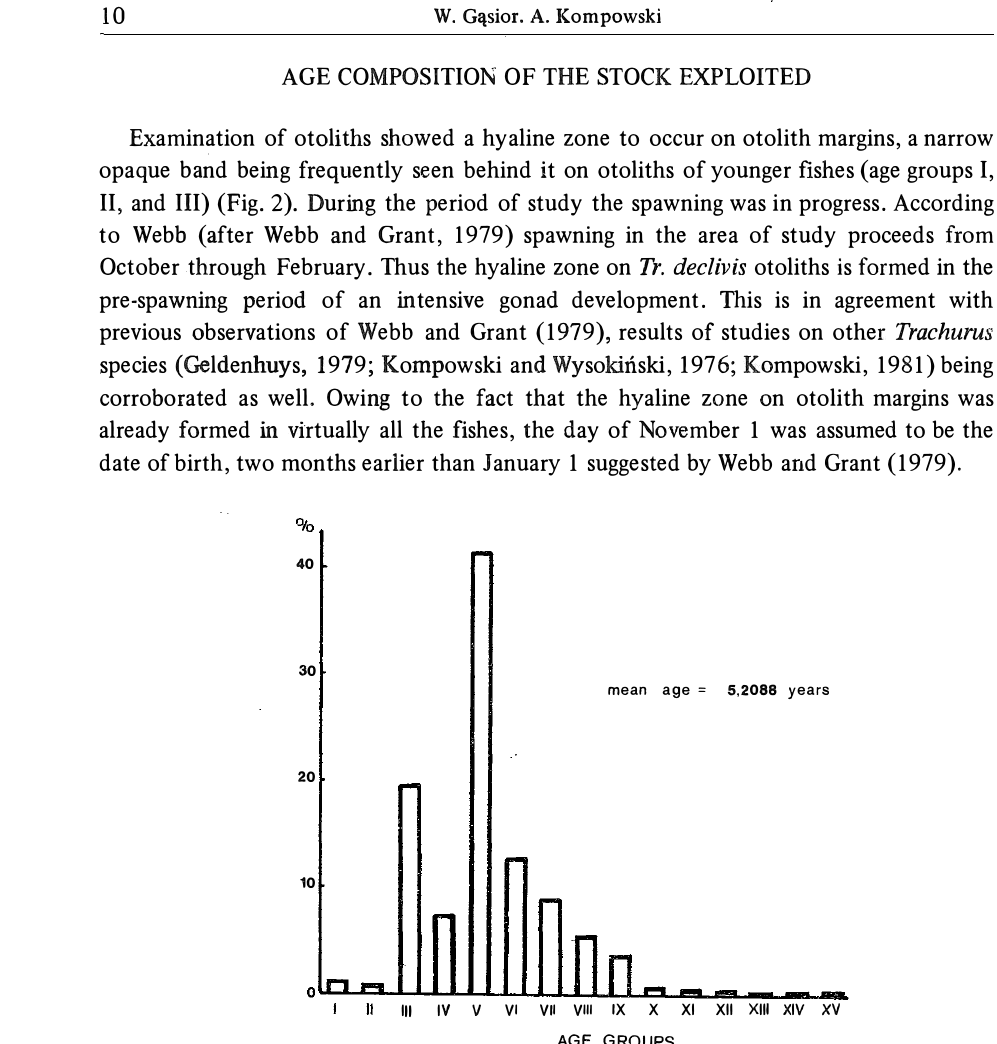
Fig. 5. Age distribution of Tr. declivis caught within Nov. 19 -Dec. 1, 1978 in shelf waters off